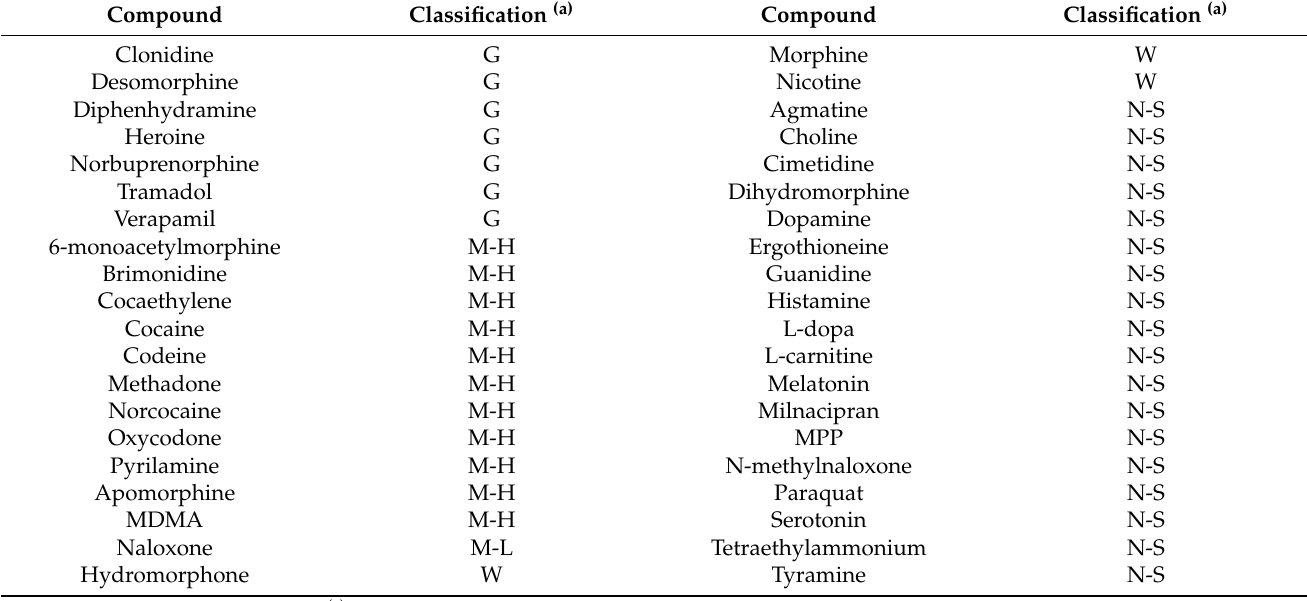
Table 1. Dataset of substrates and